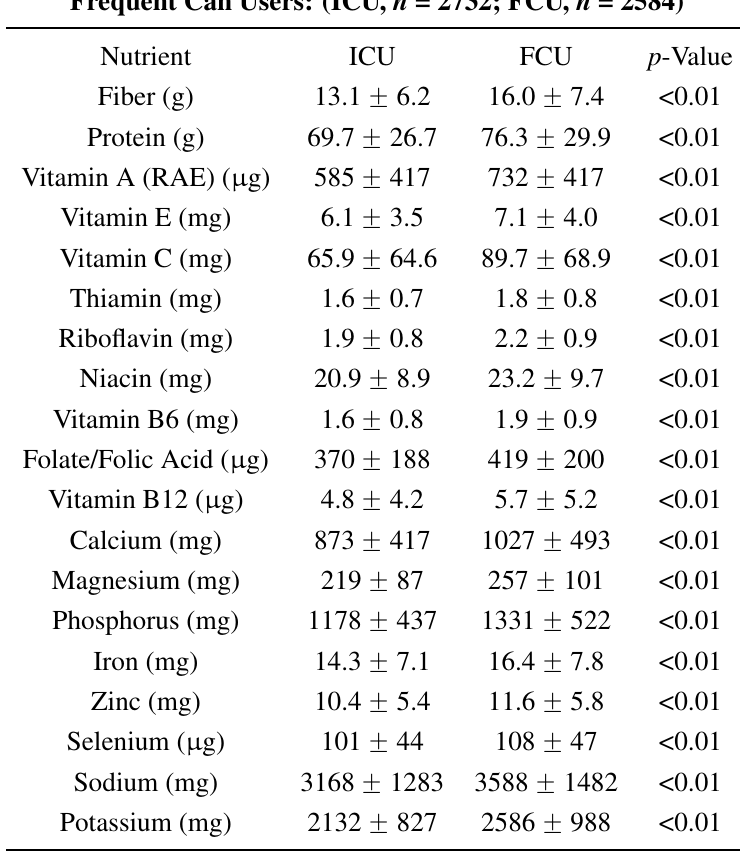
Table 2. Average daily nutrient intake between frequent and infrequent can